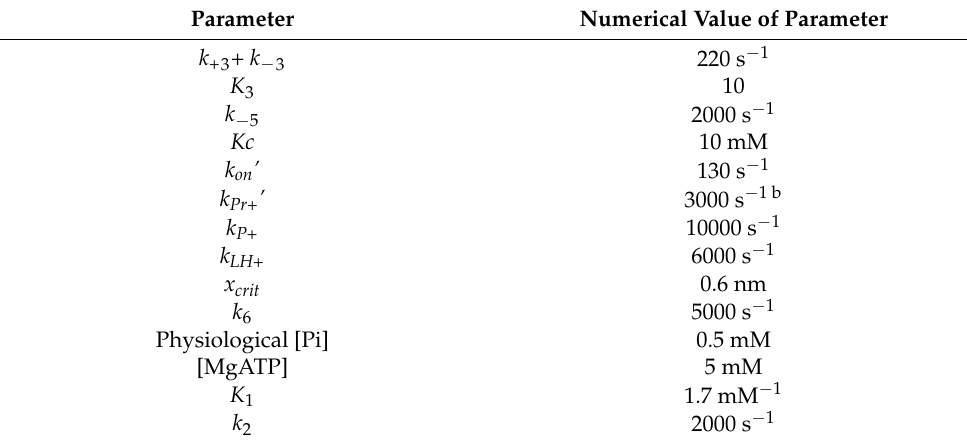
Table 2. Parameter values a for model in Figure 1 defining rate functions and kinetic constants for the simulation of contractile properties of fast mammalian muscle at 30 ◦